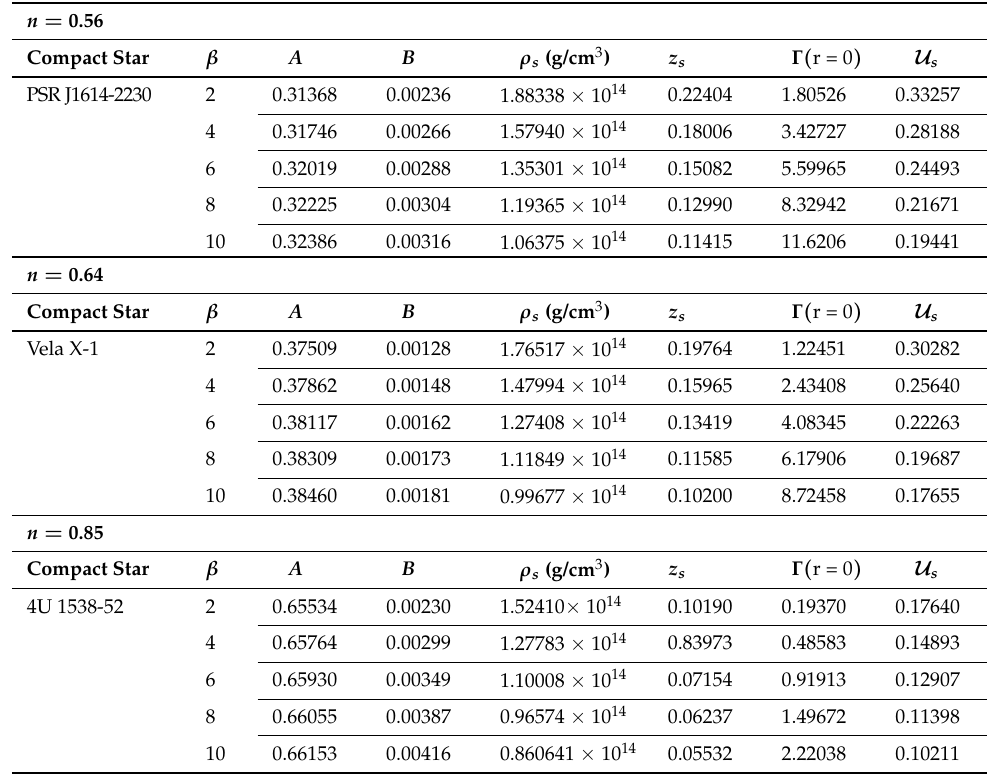
Table 2. Numerical values of constants for three well-known celestial compact stars. n =